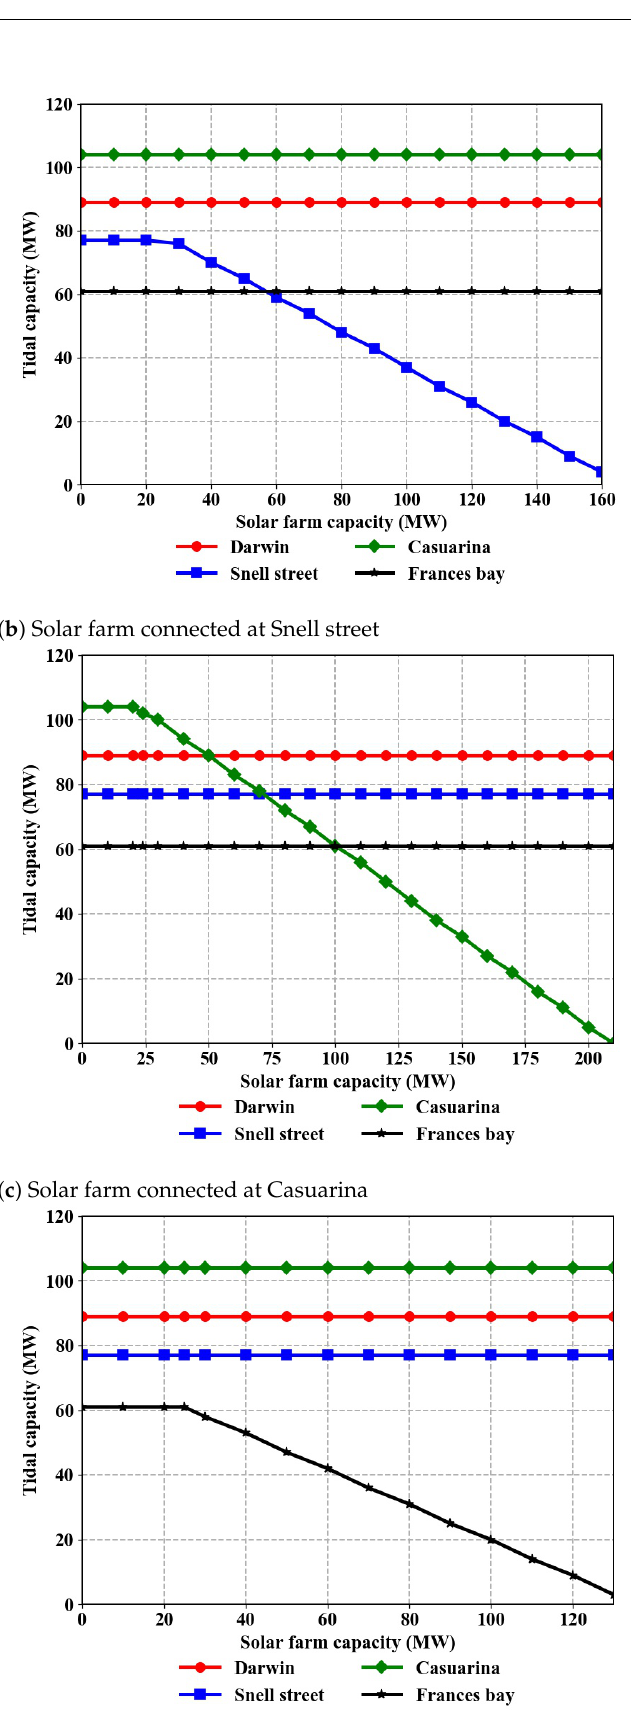
Figure 5. Impact of a potential solar farm on locational tidal HC in Darwin–Katherine